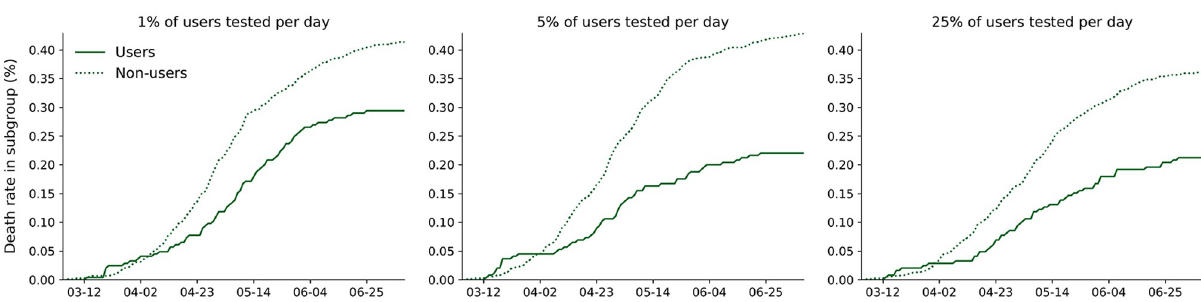
Fig 6. Cumulative death rate of users vs. non-users for the ~ N = N ¼ 25% user base consisting of neighborhoods in the overall population network. Individual contact interventions are applied within the user base from March 15 onward.